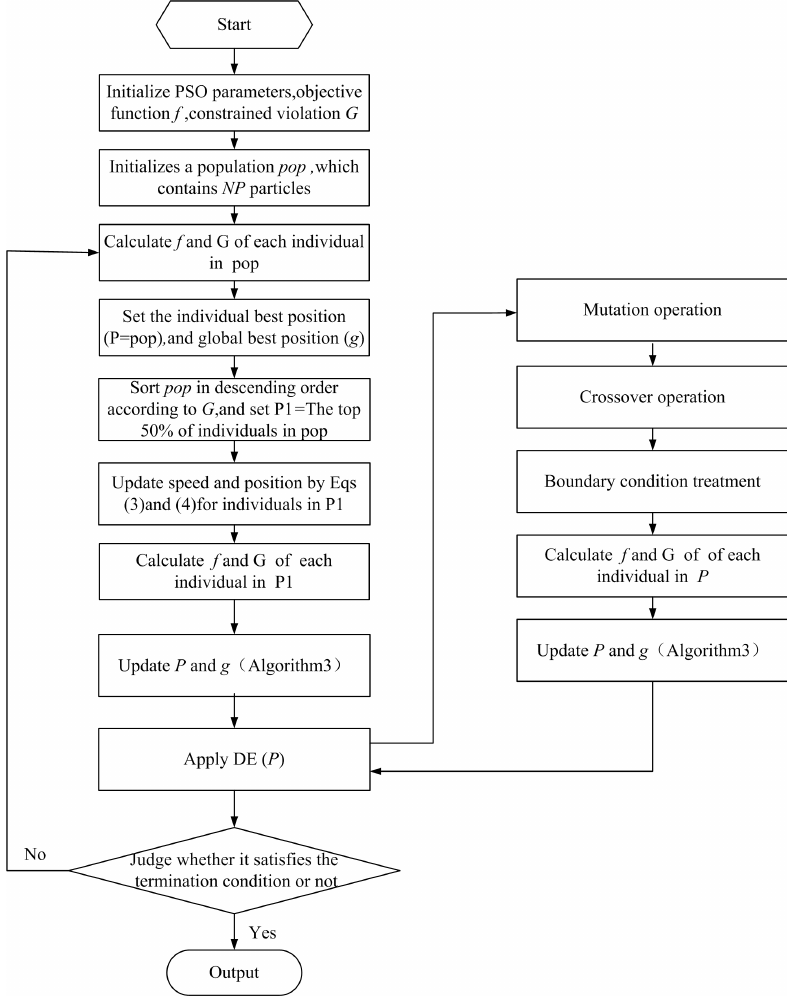
Figure 6. The basic framework of the